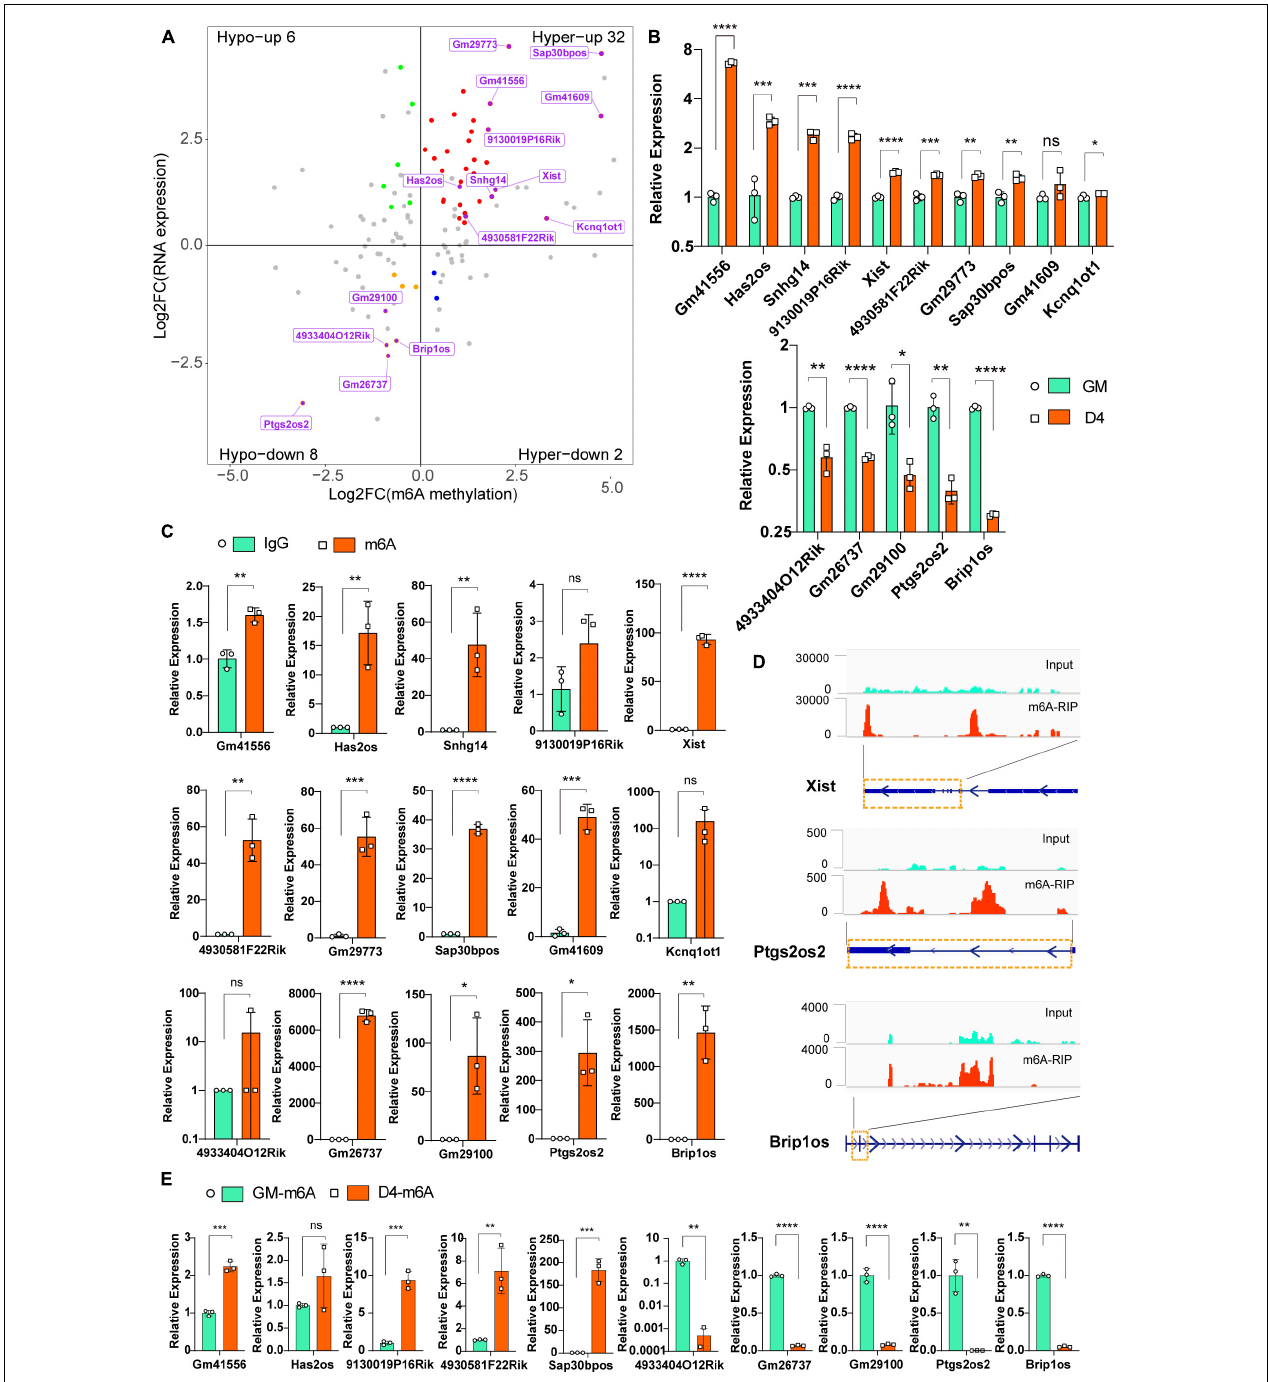
FIGURE 3 | Differentially m 6 A modified lncRNAs in undifferentiated and differentiated muscle. (A) Distribution of genes with a significant change in both the m 6 A methylation and RNA expression levels before (GM) and after differentiation (D4), different colors were used to identify representative genes. And 15 m 6 A methylated significantly differently expressed lncRNAs were marked. (B) qRT-PCR validated the 15 m 6 A methylated significantly differently expressed lncRNAs in developing muscle cells. (C) Real-time PCR detection of the expression of the 15 m 6 A methylated significantly differently expressed lncRNAs in immunoprecipitated RNAs. IgG Immunoprecipitation was used as negative control. Quantitative data was represented as Mean ± SD; p value: * p < 0.05, ** p < 0.01, *** p < 0.001, **** p < 0.0001. ns, no significant difference. (D) Integrative Genomics Viewer (IGV) plots show the m 6 A peaks of lncRNA Xist, Ptgs2os2 and Brip1os were highly enriched in m 6 A-RIP data. (E) Real-time PCR detection of the expression of the 5 hyper-upregulated and 5 hypo-downregulated lncRNAs in immunoprecipitated RNAs of GM and D4. Data were normalized by IgG Immunoprecipitation. Quantitative data was represented as Mean ± SD; p value: * p < 0.05, ** p < 0.01, *** p < 0.001, **** p < 0.0001. ns, no significant